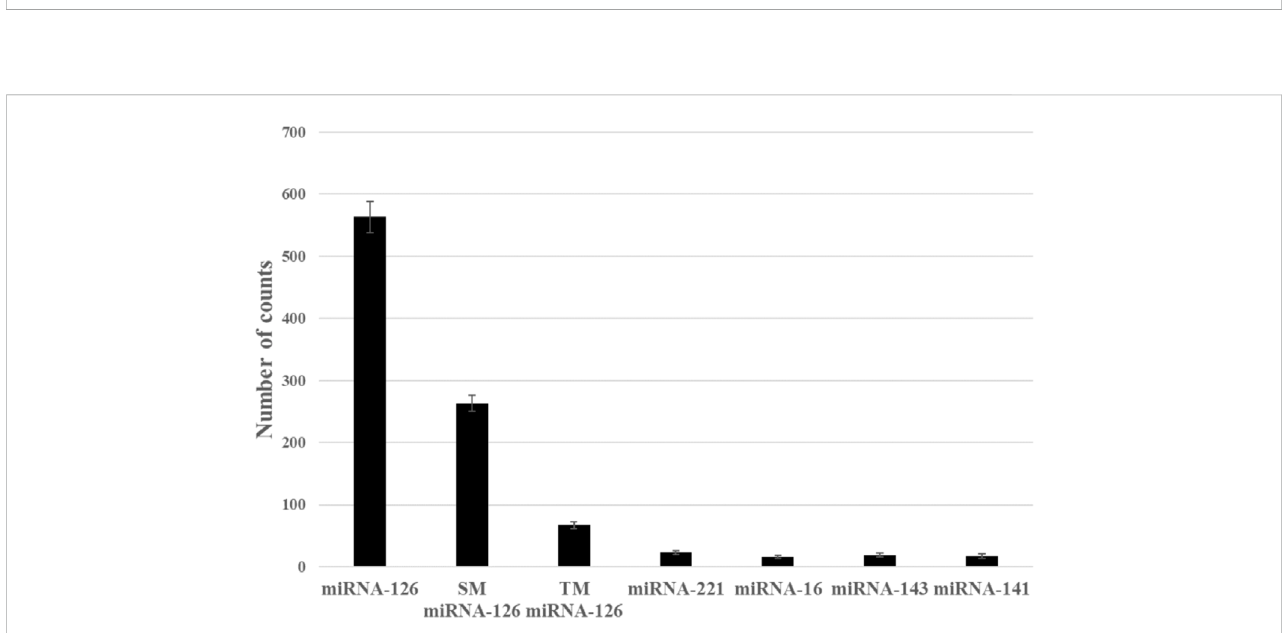
FIGURE 3 Detection speci fi city was evaluated by comparing Cy5 counts between the miR-126 sample and base mismatched miR-126 (single or three bases) sample or non-complementary miRNAs (miR-221, miR-16, miR-143 and miR-141) sample. Error bars indicate the standard deviation of three tests.